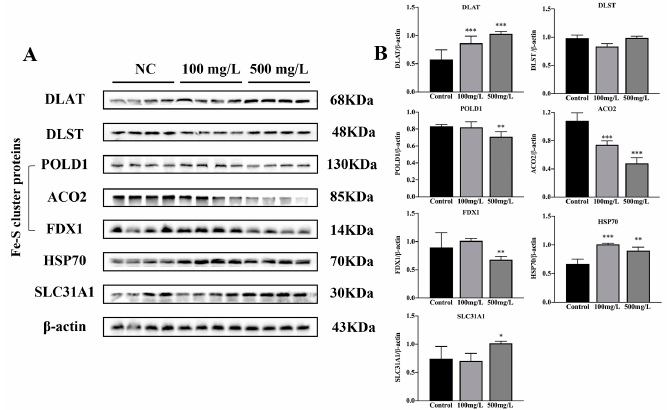
Figure 6. Effects of Cu on the expression of cuproptosis-related protein. ( A ) Proteins expression of DLAT, DLST, POLD1, ACO2, FDX1, HSP70 and SLC31A1 in mouse hippocampus. ( B ) Quantitative analysis of DLAT, DLST, POLD1, ACO2, FDX1, HSP70 and SLC31A1, * p < 0.05, ** p < 0.01, *** p < 0.001.